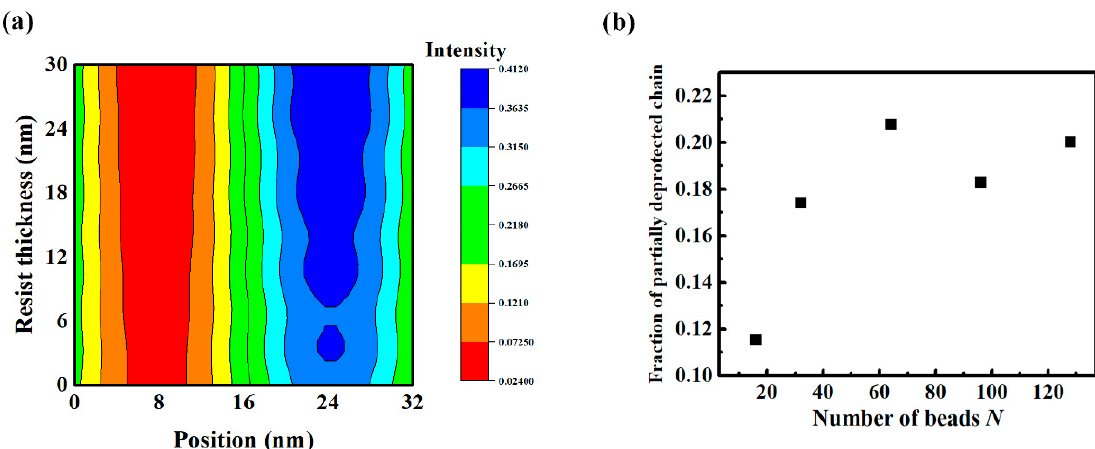
Figure 7. ( a ) Image profile implemented for 16 nm dense line and space (LS), ( b ) fraction of chains which are partially deprotected (40–60% sites deprotected per chain) as a function of the number of beads N .